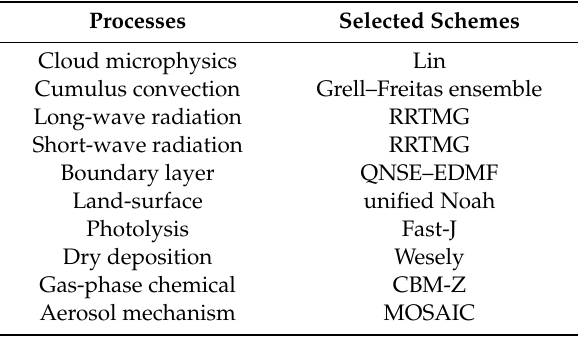
Table 1. Physical and chemical process parameterization schemes selected in this